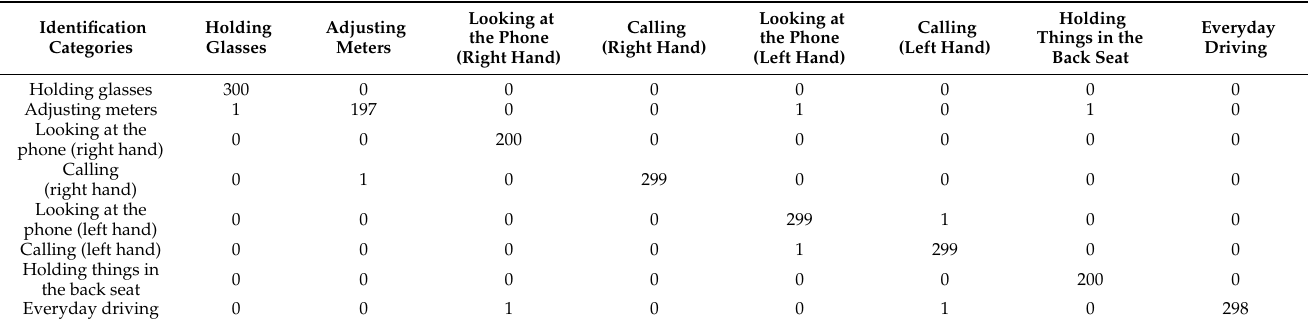
Table 3. ResNet50 driver behavior recognition confusion